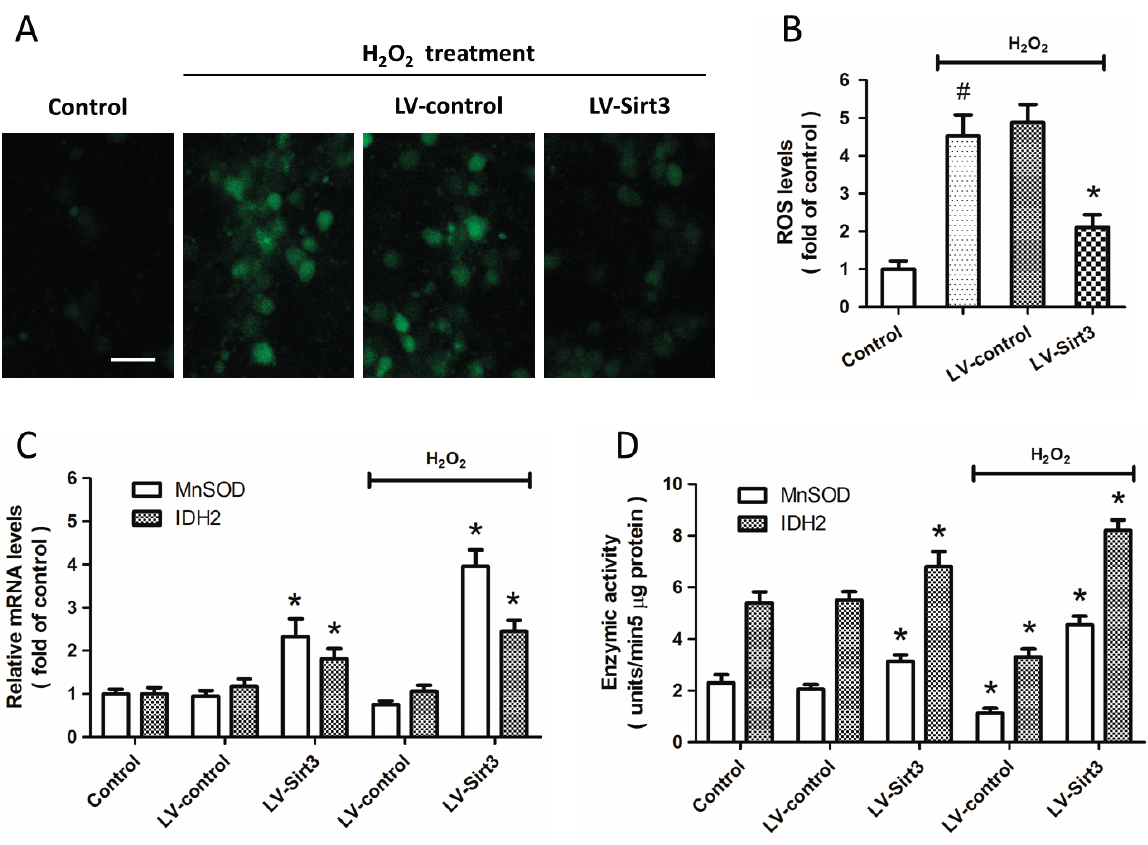
Figure 4. Overexpression of Sirt3 inhibits H O -induced oxidative stress. Cortical neurons 2 2 were transfected with lentivirus expressed Sirt3 (LV-Sirt3) or control lentivirus (LV-control) O . The ROS production was for 72 h, and then treated with or without 0.1 mM H 2 2 measured by H DCFDA staining ( A ) and calculated ( B ); The mRNA levels of MnSOD 2 and IDH2 were measured by Real-Time RT-PCR ( C ); The enzymatic activity of MnSOD and IDH2 was assayed ( D ); Scale bar: 50 μ m. Data are shown as mean ± SD of